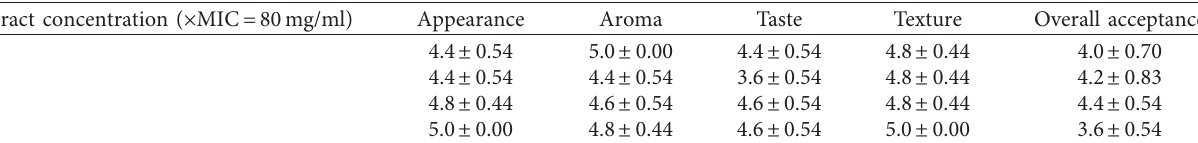
Table 6: Sensory evaluation of the emergency food products coated with different concentrations of aqueous pomegranate peel extract incorporation.